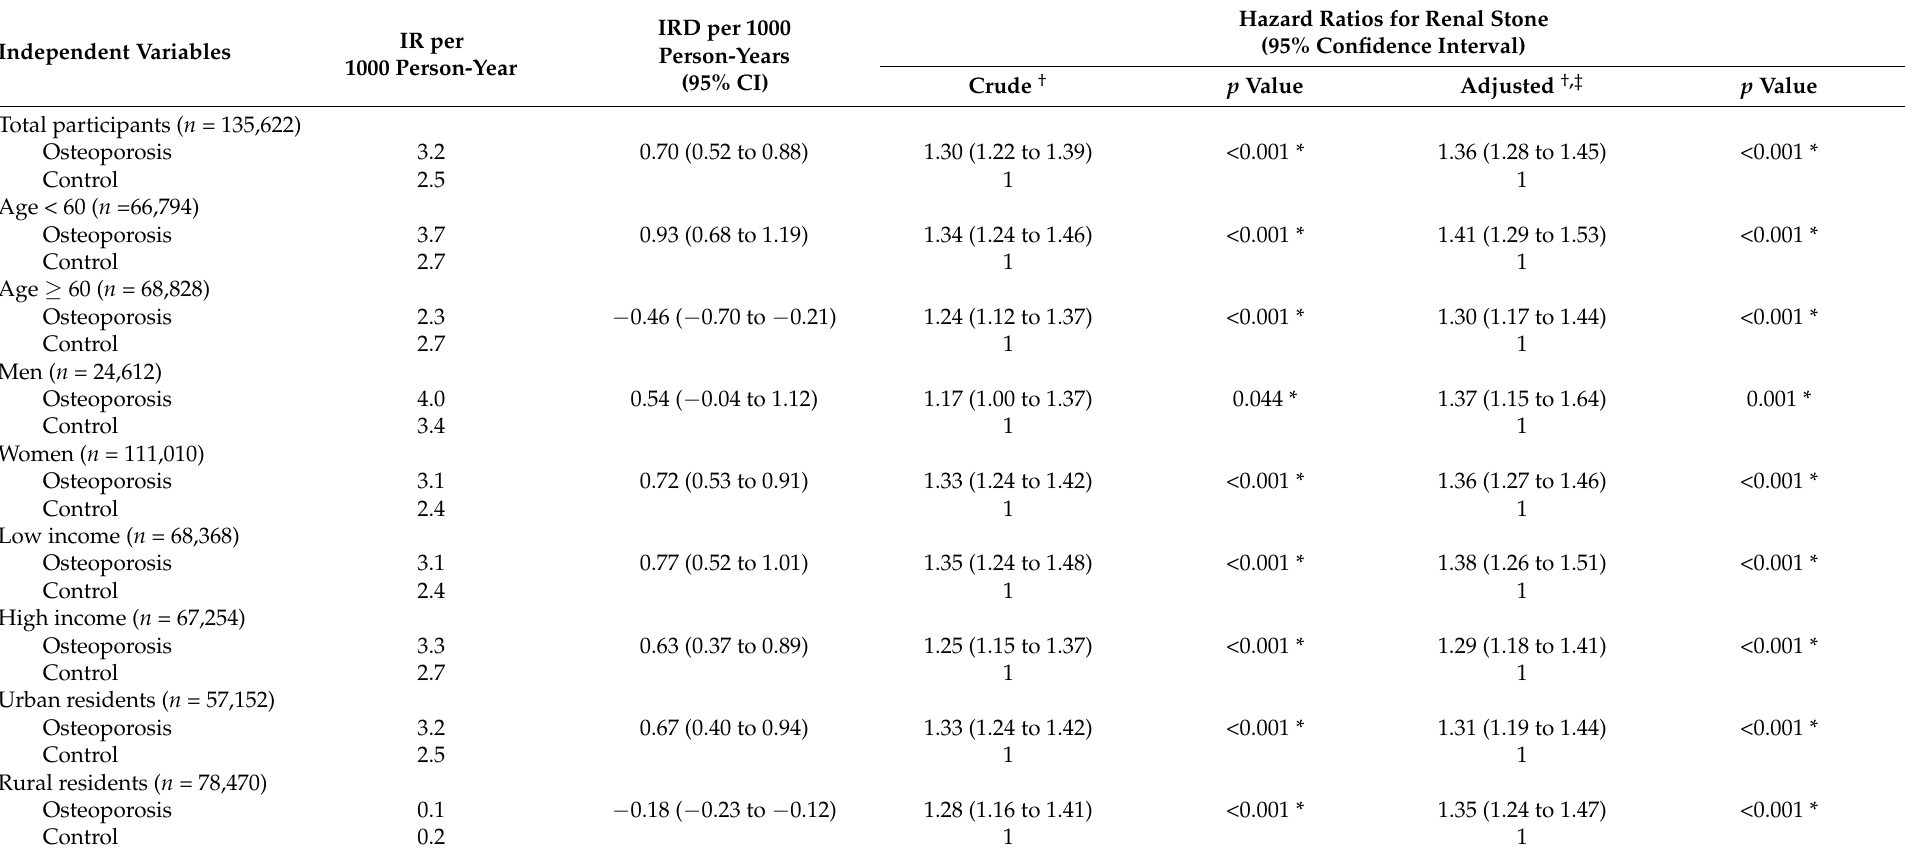
Table 2. Crude and adjusted hazard ratios of osteoporosis for renal stones by subgroup according age, sex, income, and